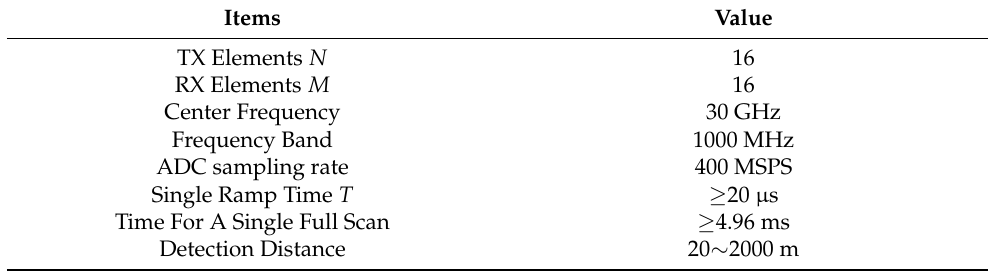
Table 3. GB-SAR system